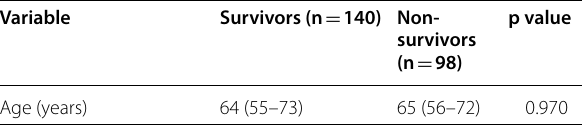
Table 1. Characteristics of in-hospital survivors and